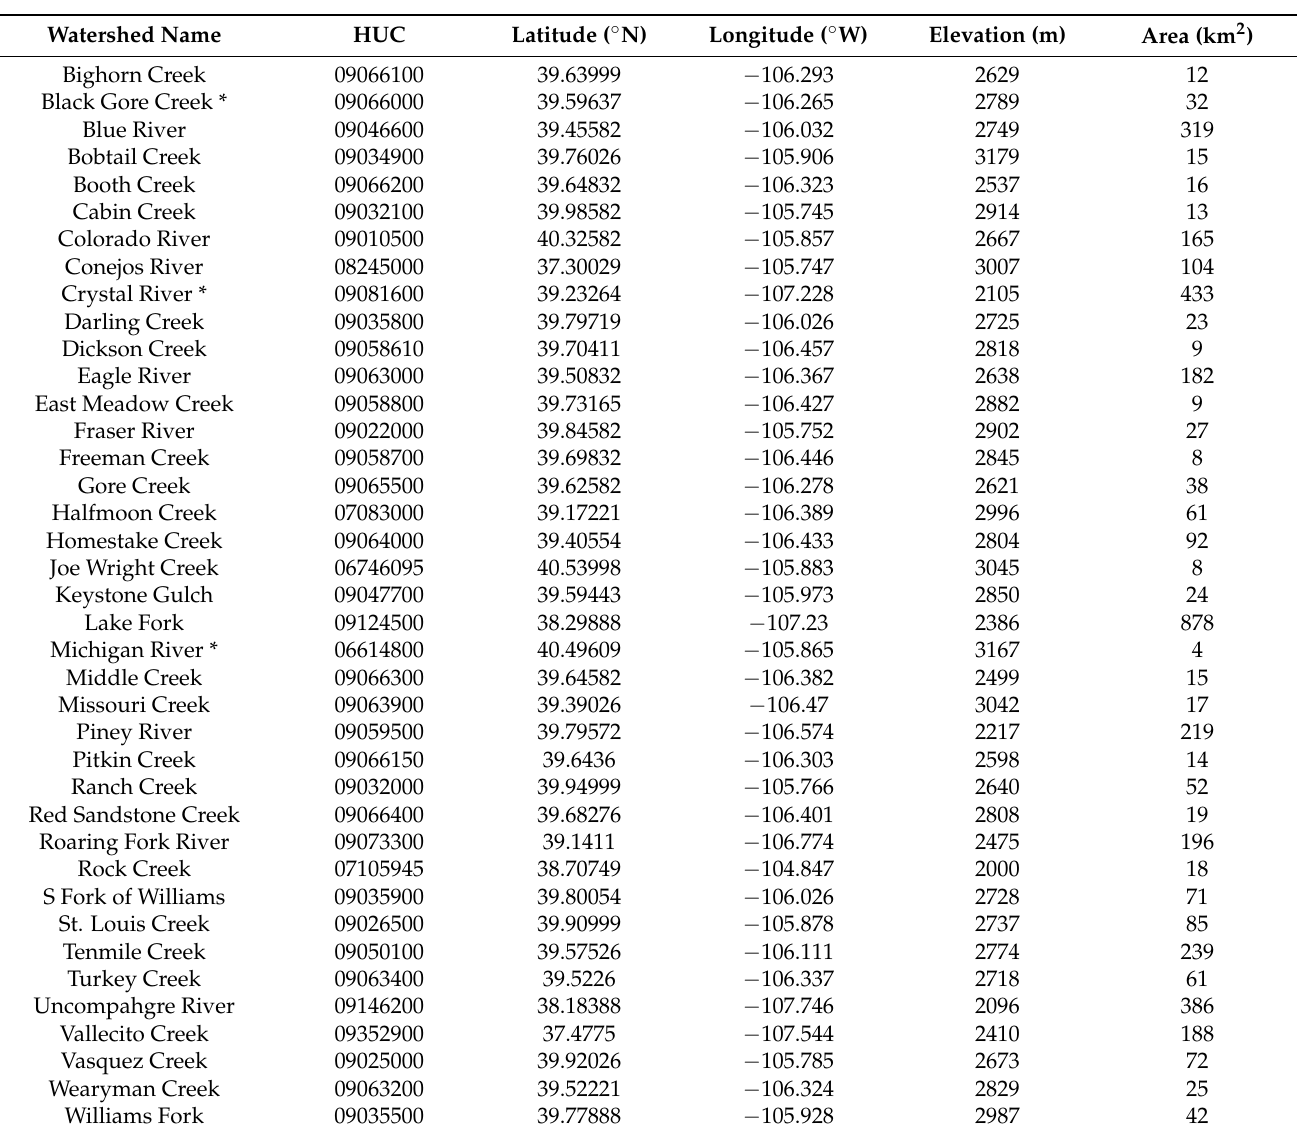
Table A1. Summary of the watersheds used in the assessment of the new method. This includes the following: U.S. Geological Survey station number, area, outlet elevation, and outlet location (latitude and longitude). The watersheds examined in detail are denoted with an asterisk